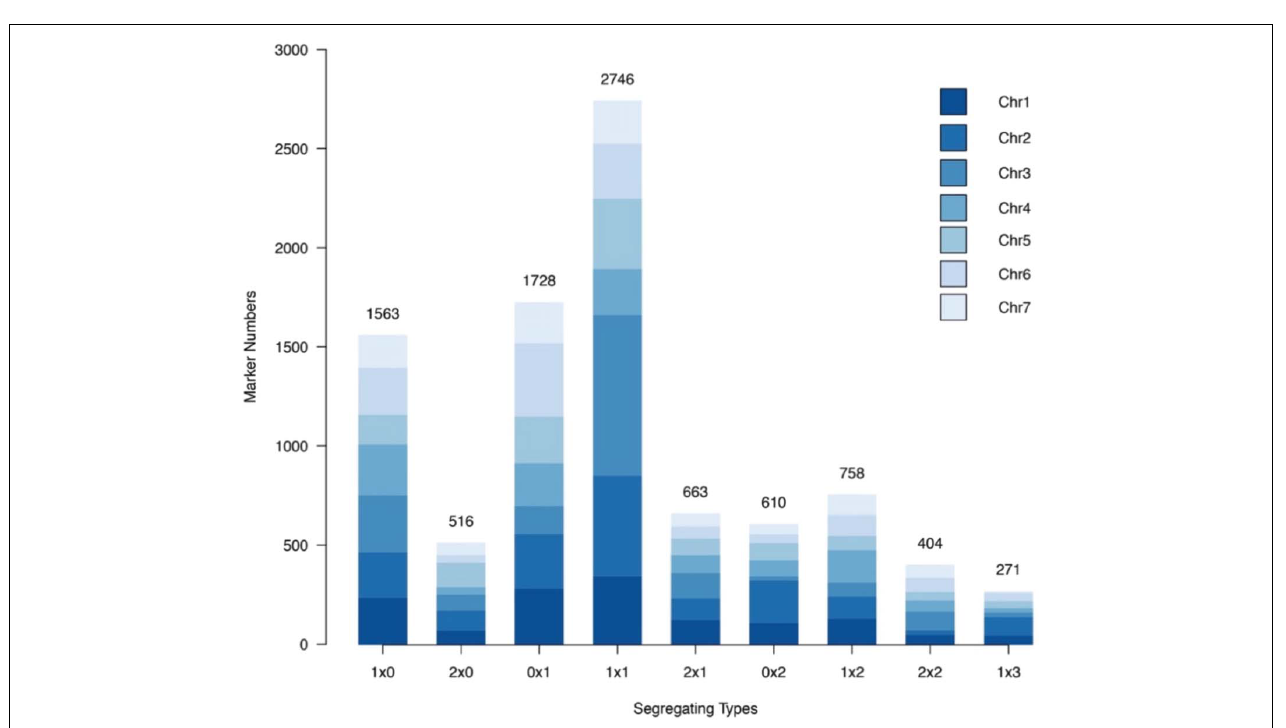
FIGURE 3 | Frequency distribution of carotenoid contents in the tetraploid rose YS population. (13 Z ) + (di- Z )-Vio; (13 Z ) + (di- Z )-violaxanthin; (all- E )-Vio, (all- E )-violaxanthin; (9 Z )-Vio, (9 Z )-violaxanthin; TE, total epoxycarotenoids; TH, total hydroxycarotenoids; TX, total xanthophylls; THB, total hydrocarbons; TC, total carotenoids.